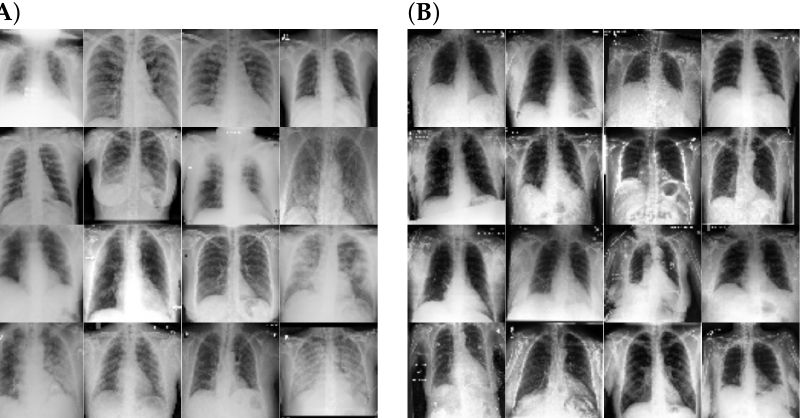
Figure 6. A total of 16 images randomly sampled from each of the ( A ) COVID class and ( B ) non- COVID class. The images for the COVID class appear cloudier and more unclear than the images for the non-COVID class. This is because in the X-ray images for the COVID class contain substances that are not air. These substances may be liquid, germs, or inflammatory fluid, which causes the images to have cloudy, unclear, and shady